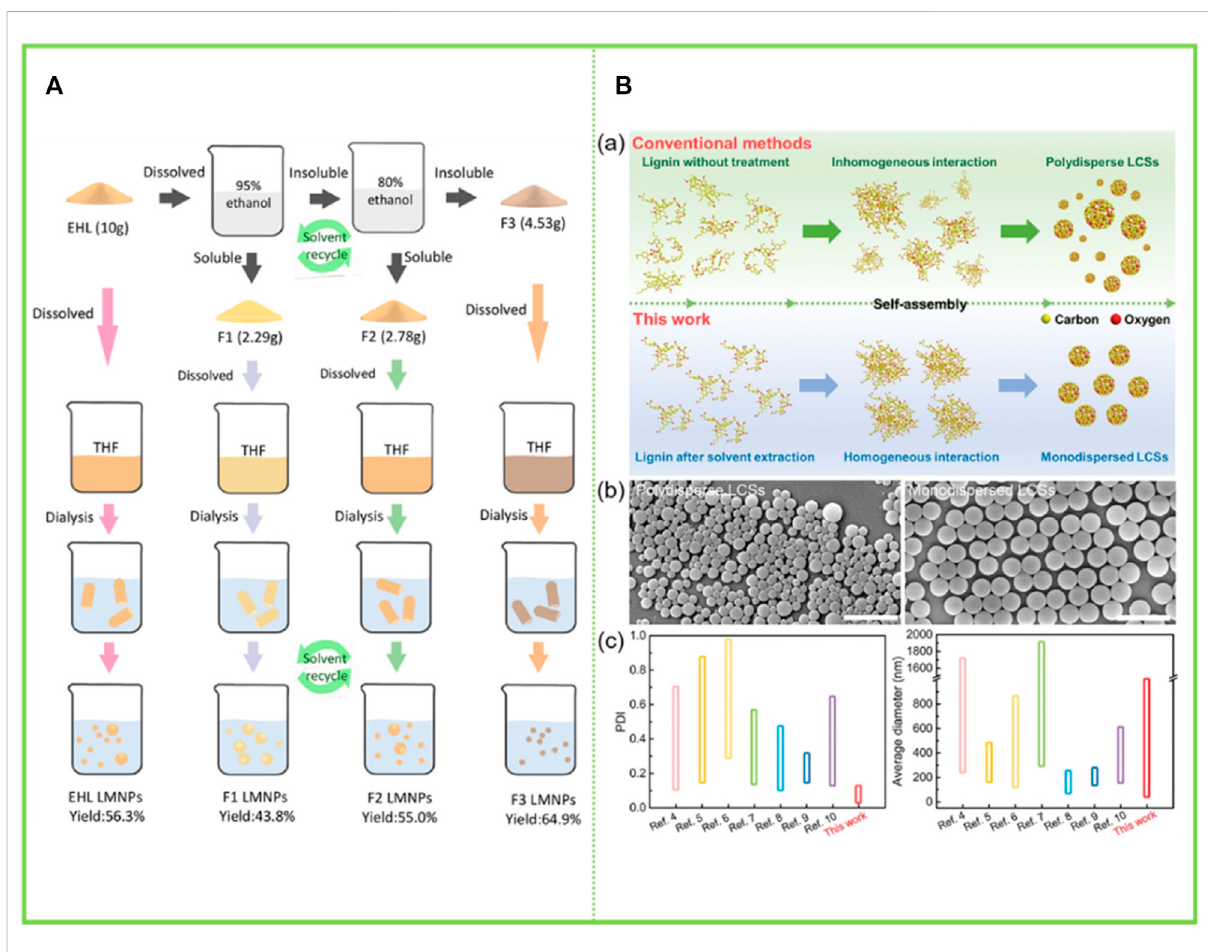
FIGURE 6 (A) Scheme for EHL fractionation by sequential dissolution in 95% and 80% ethanol/water solvents and thesequent ligninmicro/nano-particles (LMNPs) preparation using anti-solvent precipitation method (self-assembly) (Pang et al., 2020) (B) Strategy for preparing monodispersed LCS with tailorable size (Wang et al., 2022). (A) Copyright 2020 American Chemical Society (B) Copyright 2022